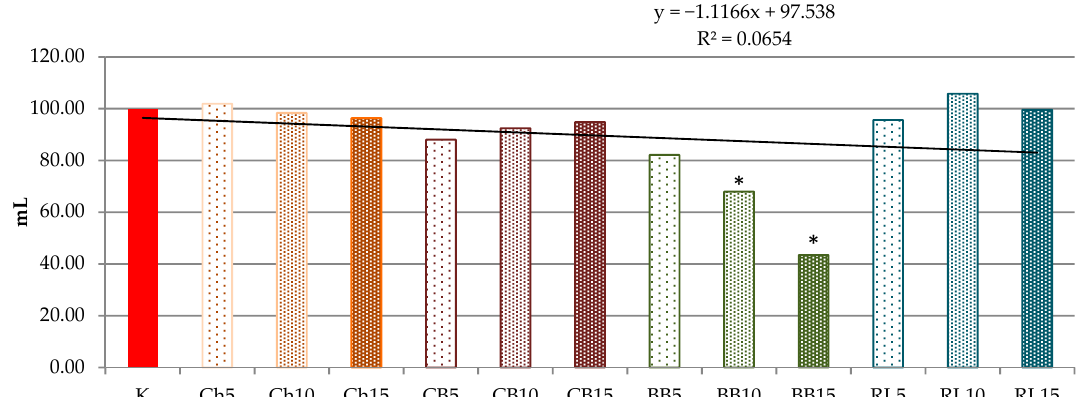
Figure 7. Retention volume—CO 2 volume in mL still retained in the dough at the end of the test, by Rheofermentometer, calculated in % in comparison to a control sample WF(50)+RF(50). The trend line indicates a trend of decreasing retention volume in doughs with the addition of legume flour. * values are significantly different ( p < 0.05) compared to control. K = WF(50) + RF(50); Ch5 = WF(50) + RF(45) + ChF(5); Ch10 = WF(50) + RF(40) + ChF(10); Ch15 = WF(50) + RF(35) + ChF(15);